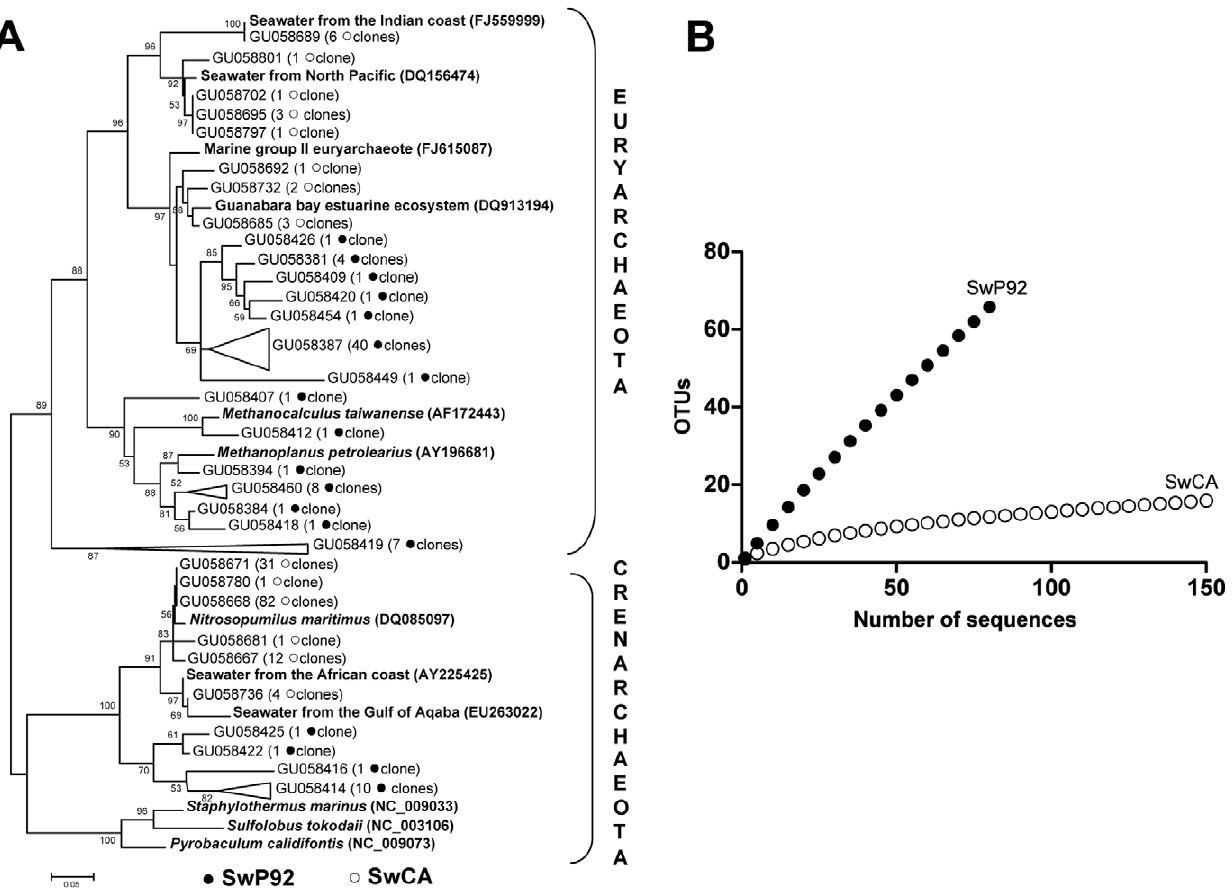
N N ) inner bay (P92) clones ) inner bay (P92) sequences ( # ) Cagarras Archipelago (CA)